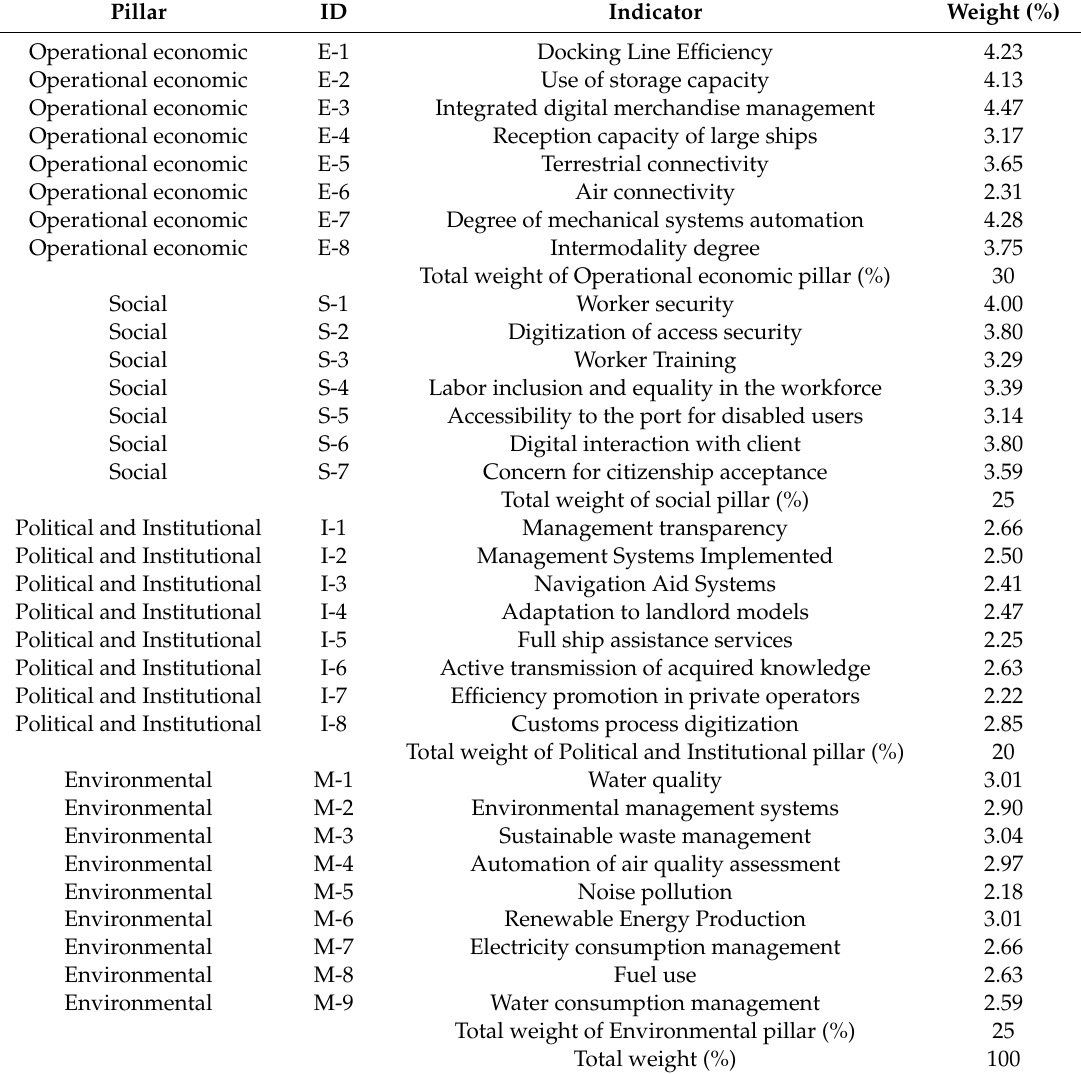
Table 2. Particular weight of each indicator over global Smart Port